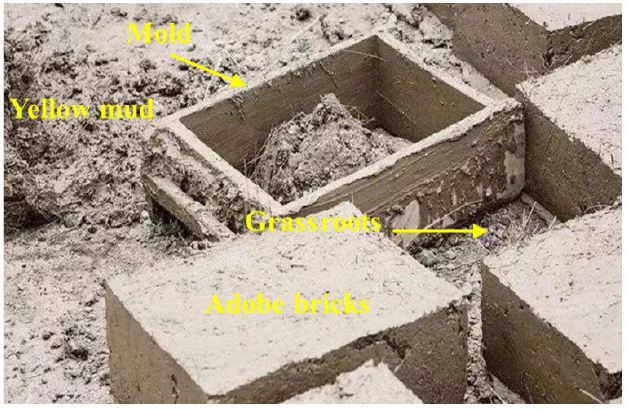
Figure 4. Mud brick materials.